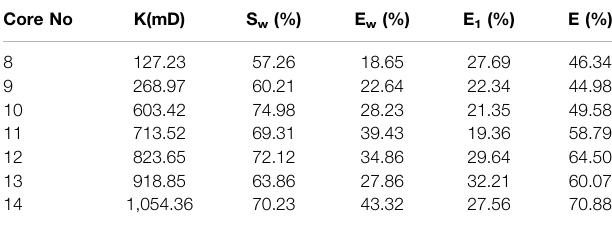
TABLE 2 | m -HPAE/LAS fl ooding